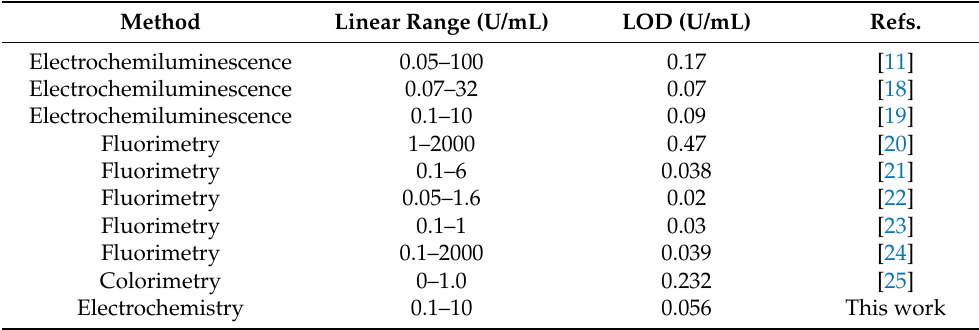
Table 1. The comparison of the sensing performance of the proposed biosensor with other methods for